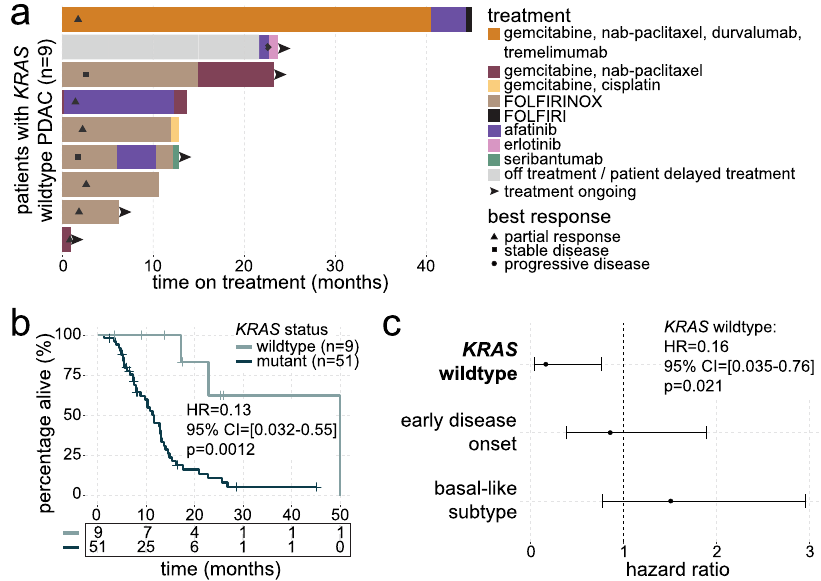
Fig. 1 | Administration of targeted treatment regimens in patients with KRAS wildtype mPDAC. a Swimmer ’ s plot showing the duration of each treatment regimenreceivedbyeachpatientwith KRAS wildtypemPDAC( n =9).Bestresponse to fi rst-line therapy is indicated by black symbols. Black arrows at the end of bars indicate patients who remain on treatment. b Kaplan – Meier curve comparing overall survival between KRAS wildtype ( n =9) and mutant ( n =51) groups. Hazard